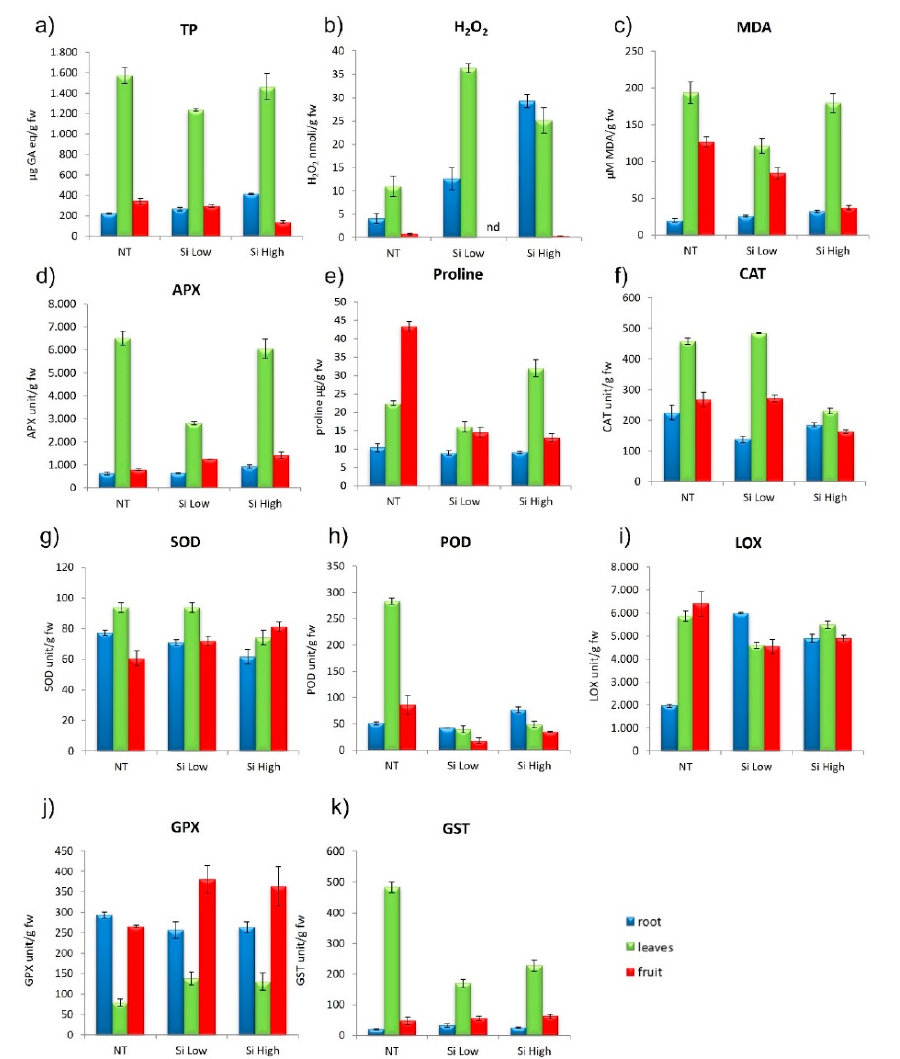
Figure 4. Effect of Si Low and Si High physiological parameters in cvs. Gladis: ( a ) total phenolic (TP), ( b ) hydrogen peroxide (H 2 O 2 ), ( c ) lipid peroxidation (MDA), ( d ) ascorbate peroxidase (APX), ( e ) proline, ( f ) catalase activity (CAT), ( g ) superoxide dismutase activity (SOD), ( h ) peroxidase activity (POD), ( i ) lipoxygenase (LOX), ( j ) glutathione peroxidase (GPX), ( k ) Glutathione S-transferases (GST). Values equal to 0 means below detection limit (nd). ANOVA was performed followed by Tukey’s HSD test. Tukey’s p values are explicated in Tables S6 and S7.